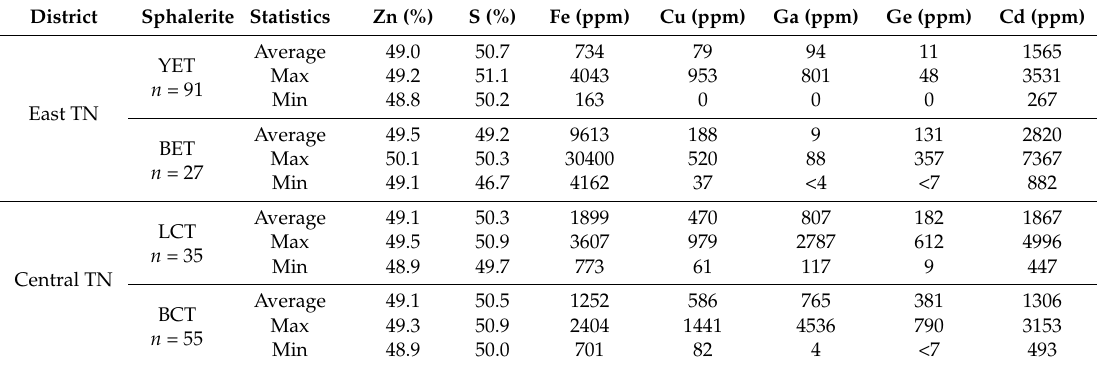
Table 1. Average trace element contents in sphalerites from Central and East Tennessee (analysis by LA-ICP-MS) (% Atomic for Zn and S and ppm for the others).